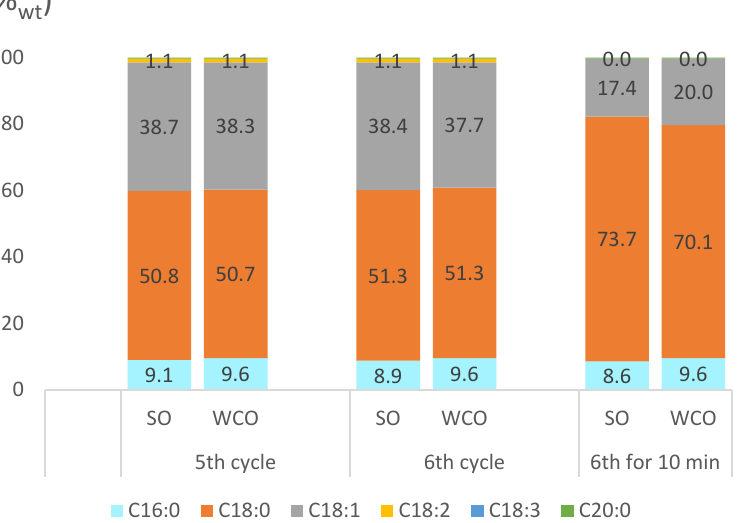
Figure 8. SO and WCO FAMEs compositions (%wt) after the fifth and the sixth runs with the same Pd-pol catalyst. Reaction conditions: SO or WCO biodiesels (125 mg), Pd-pol (0.014 mmol of Pd), and CH3OH (5 mL), at RT, H 2 (10 bar), and t = 5 min. The last two histograms refer to the sixth cycle over a 10-min reaction. In all of the histograms, the percent of C20:0 methyl ester is equal to 0.3%.